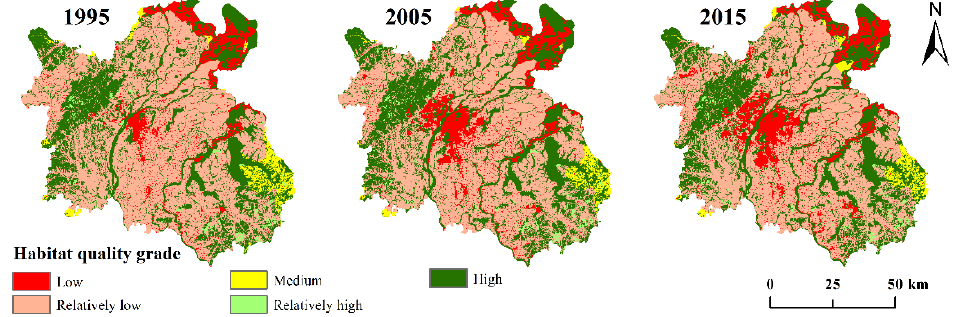
Figure 6. Spatial distribution pattern of habitat quality in 1995, 2005, and